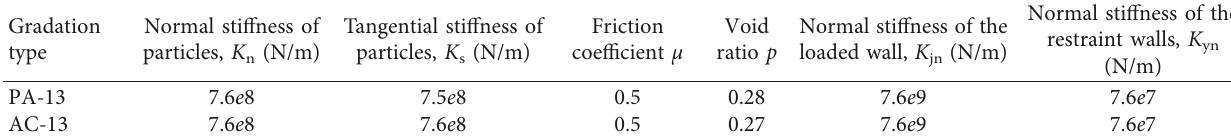
Table 5: Values of the microscopic parameters of graded mixtures.